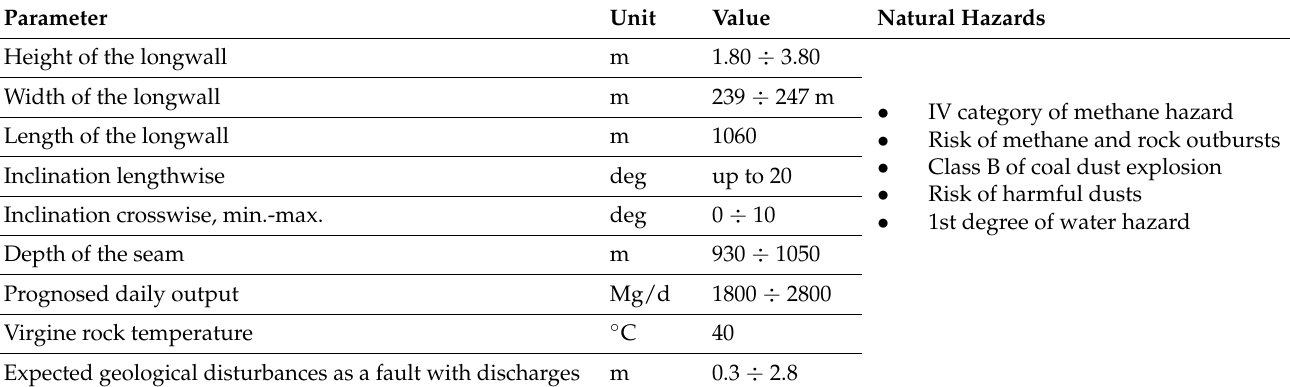
Figure 10. Scheme of the excavation in the B-15 longwall area with the drainage gallery. Table 5. Technical parameters and natural hazards present in the longwall panel B-15 seam